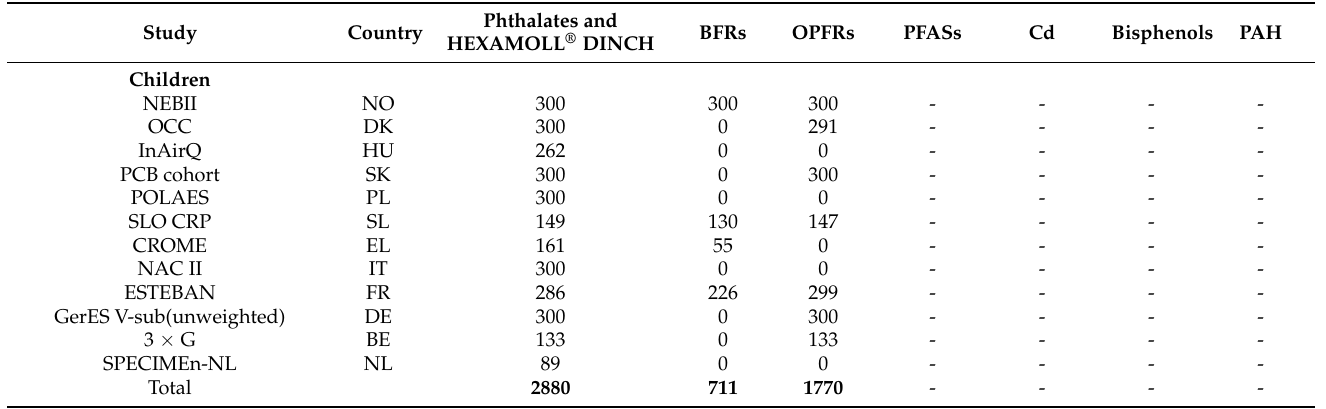
Table 2. Number of subjects analyzed per substance group for the entire HBM4EU-aligned studies and per